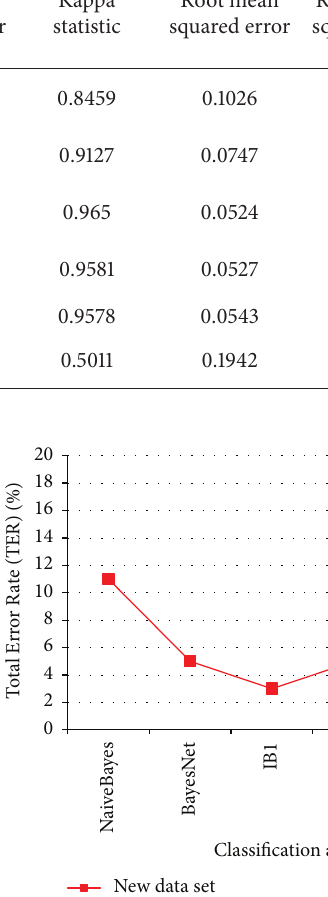
Figure 4: The true optimistic ratio for the classifications test in the new data set. Figure 5: The Total Error Rate (TER) for the classifications test in the new data set.